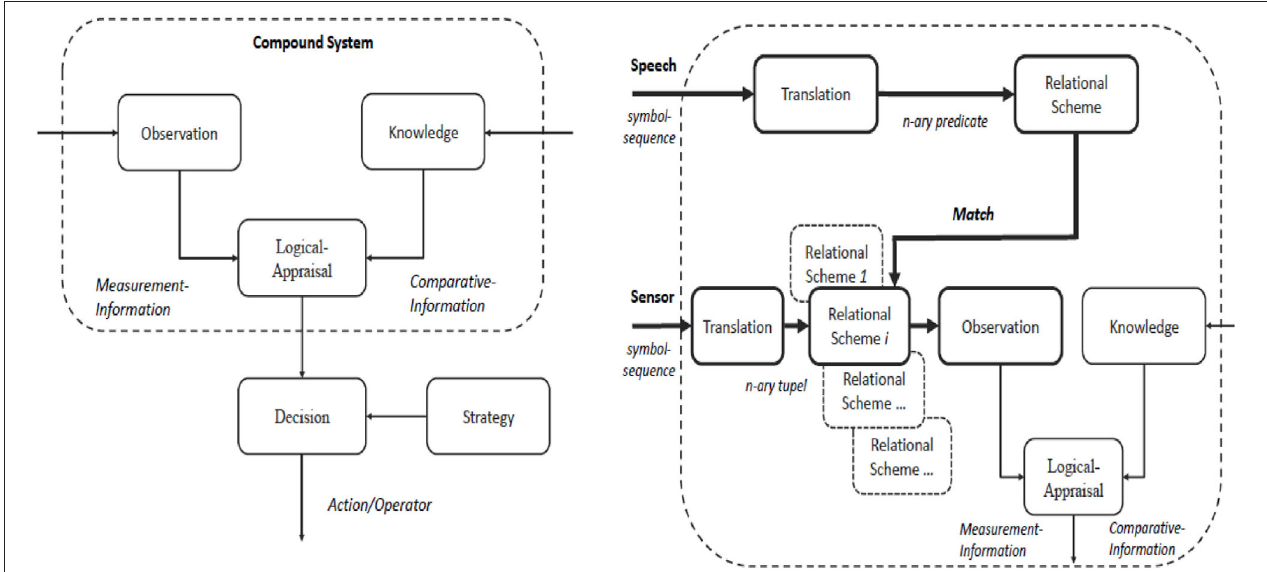
FIGURE 4 | Left: A logical compound system compares measurement information and model knowledge, subsequently a strategy based action is selected. Right: Merging of sensory information (interaction) and language information (communication) based on a double cognitive